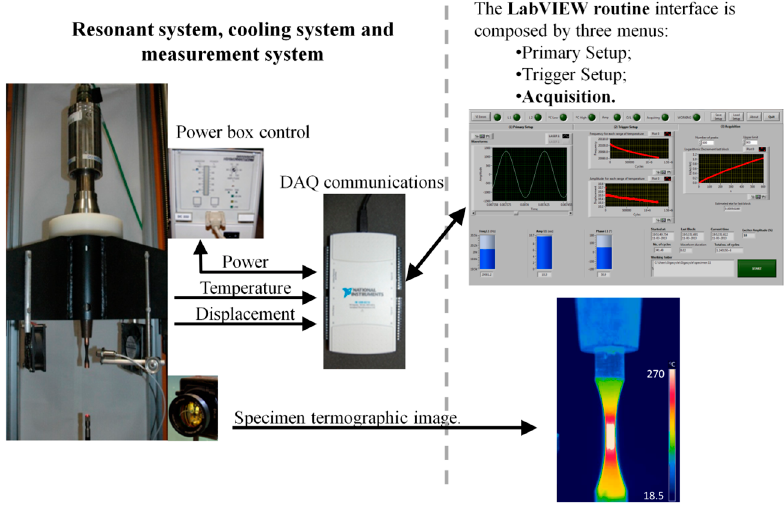
Figure 4. Schematic representation of the typical systems found in a UFT machine [10].